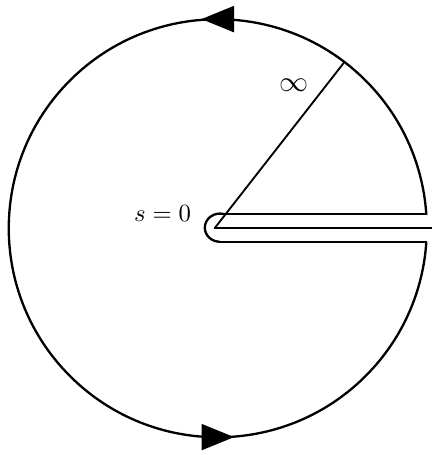
Figure 1 . The integration contour C used for the DR of T ( J ) ( s ) − 1 in eq.